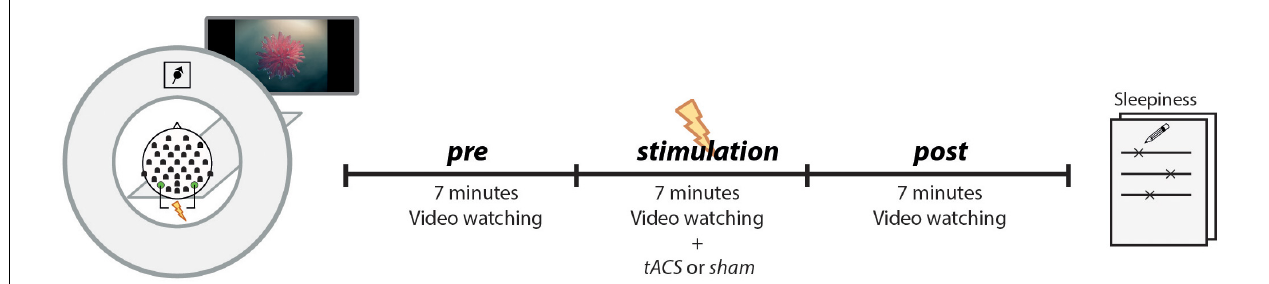
FIGURE 1 | EEG and fMRI data were simultaneously recorded during three runs ( pre , stimulation , post ), while subjects passively watched the same video each run. During the second run (stimulation), subjects received a continuous stimulation at their IAF (tACS-session) or only a 10-s ramp-up/ramp-down stimulation (sham-session). The tACS electrodes were placed at PO7/PO8 positions, and the EEG was recorded from 31 electrodes. After the experiment, subjects retrospectively rated their sleepiness during each run on a continuous line ranging from sleepy to very awake